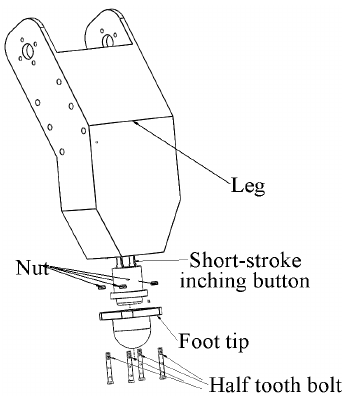
Figure 2. The hexapod robot’s foot sensing structure.